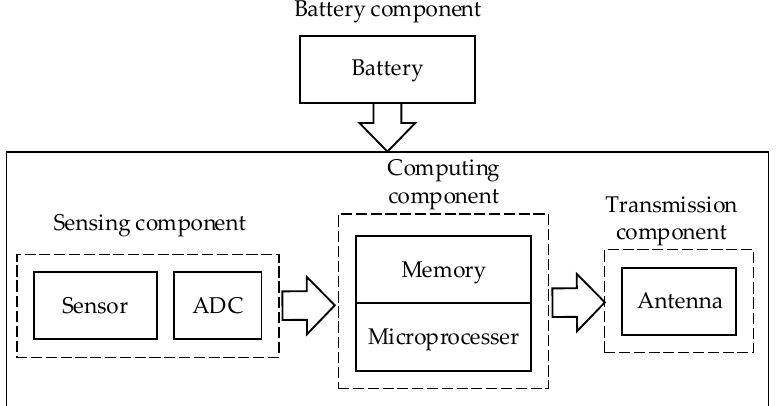
Figure 1. A typical sensor node